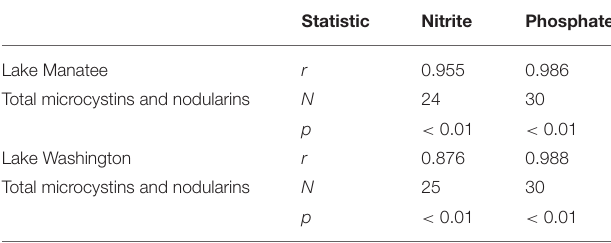
TABLE 3 | Correlation coefficients for nutrients and total microcystins and